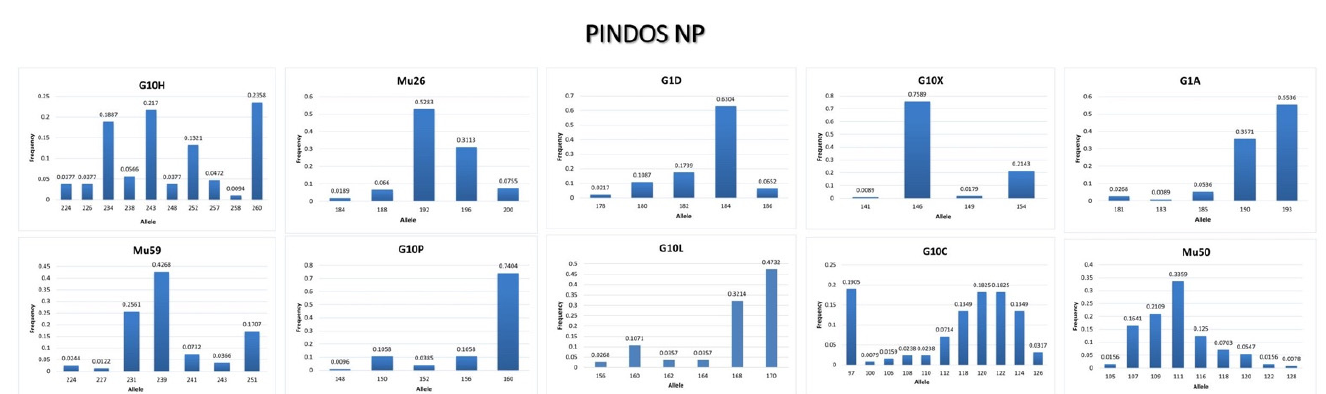
Figure 4. Allele frequency of each microsatellite locus of the brown bear population in Pindos NP. Table 4. Number of homozygotes, heterozygotes, and alleles that are present at each locus (Pindos NP).